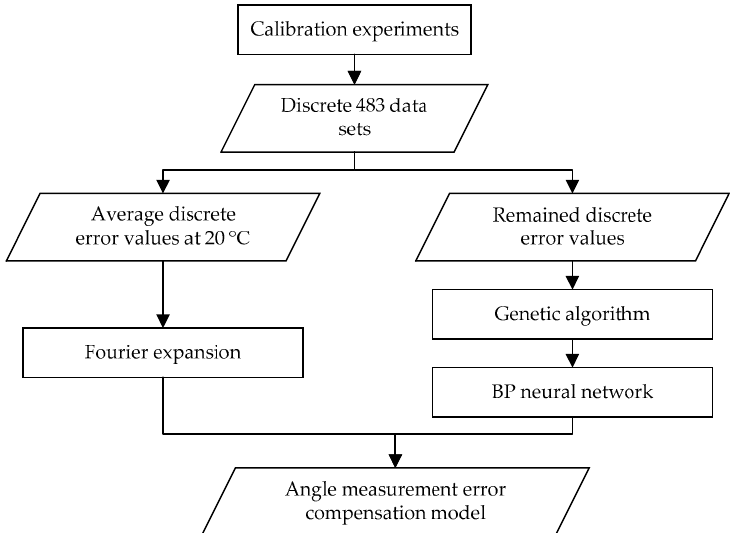
Figure 2. Structure of the Fourier expansion-back propagation (BP) neural network optimized by genetic algorithm (FE-GABPNN).